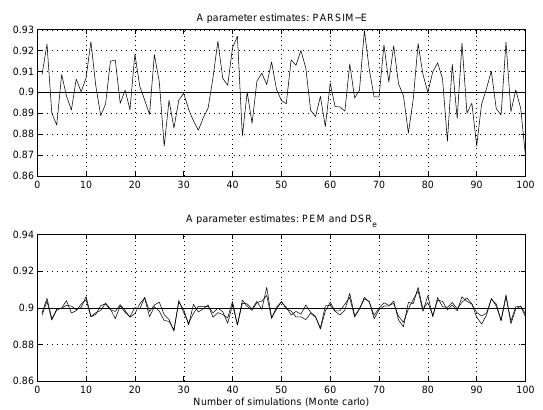
Figure 1: Pole estimates of the closed loop system in Example 7.1 with parameters as in Case 1.